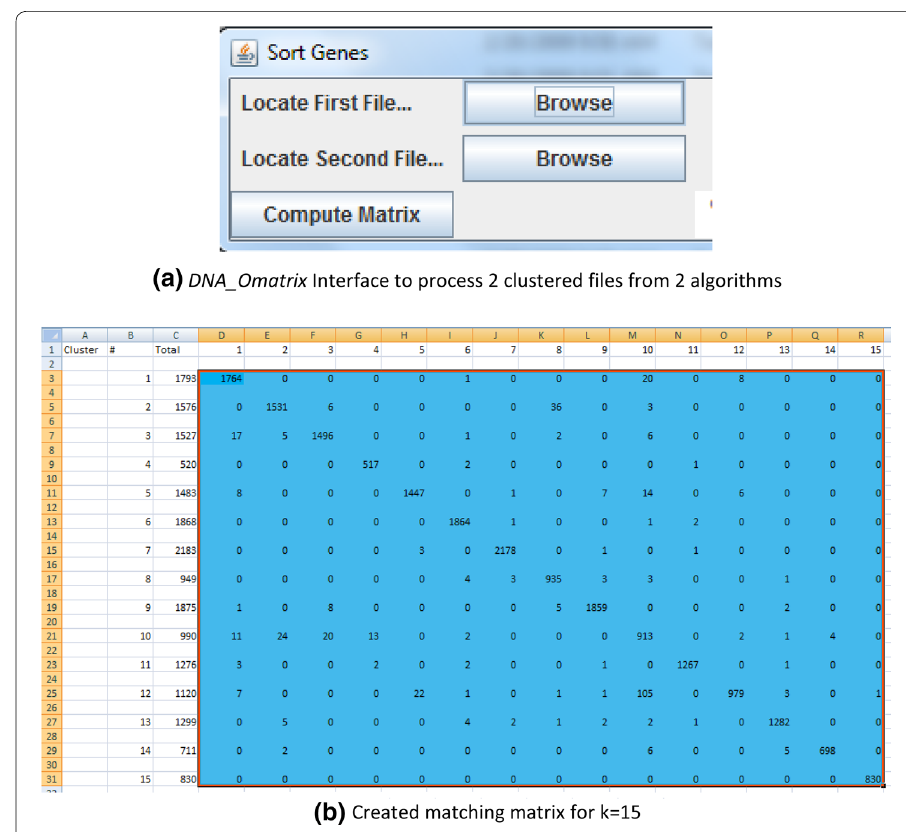
Fig. 2 a Interface of DNA_Omatrix with ( b ) Matching matrix for Bozdech et al.(2003) 3D7 Data comparing two algorithms (Traditional k-means vs Overlapped